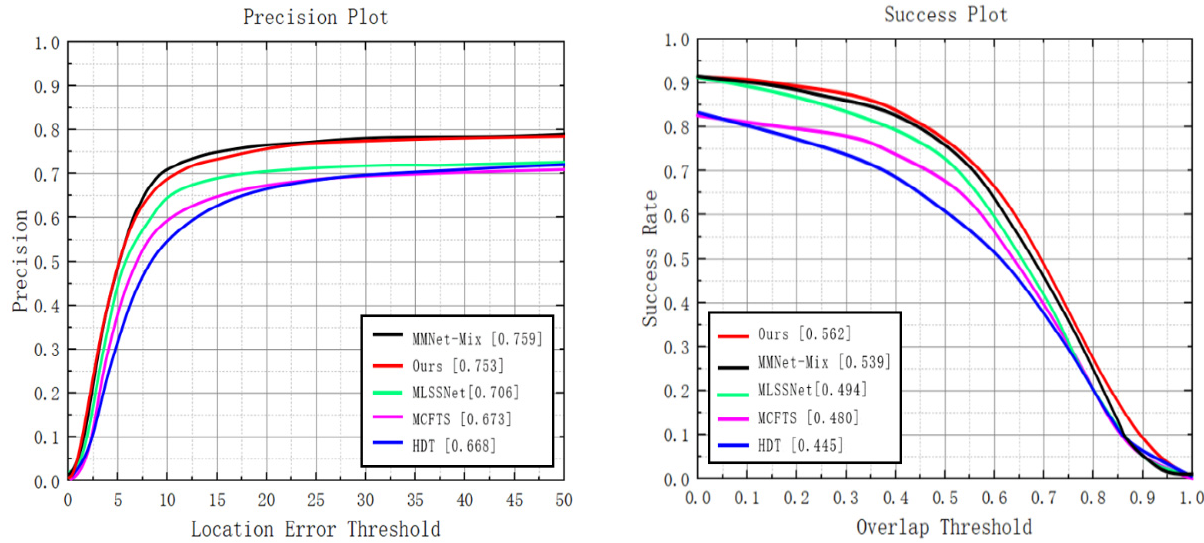
Figure 13. Comparison results with existing methods in the PTB-TIR dataset.